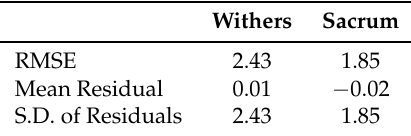
Table 7. Summary of difference statistics for the upper-body vertical displacement signals (values in